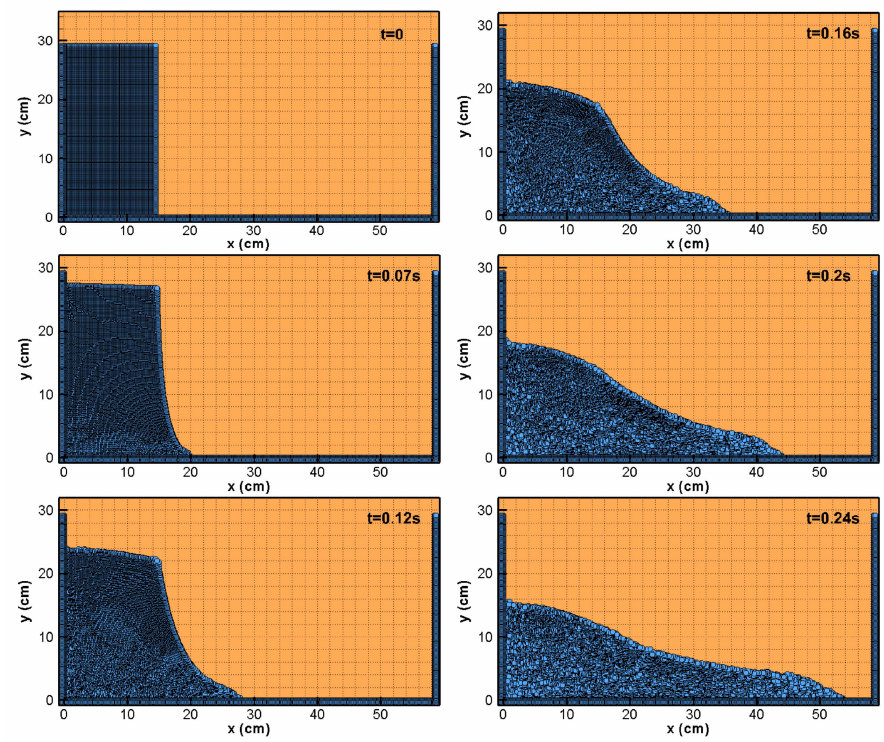
Figure 6. Particle configuration for dam-break computed by the WC-MPS method.